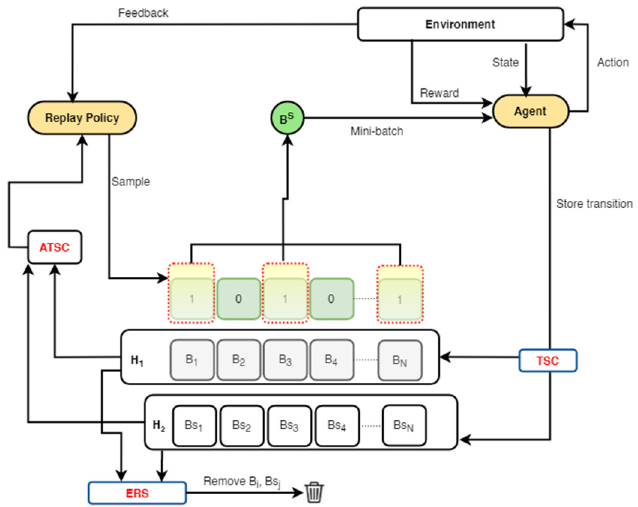
Figure 3. Framework 1: this framework combines experience replay optimisation (ERO) with a dual memory and an alternating transition selection control (ERO-ATSC) without a transition storage control (TSC) mechanism. Transitions from the environment are stored in only H1. When a specified mini-batch size is reached, the replayed transitions from H1 are stored in H2. The ATSC uses a defined ratio to sample a mini-batch of transitions from either H1 or H2 into the replay policy network. These transitions are vectorised and prioritised and uniformly sampled at random to train the agent. Feedback from the training environment is sent to the replay policy network for policy evaluation.